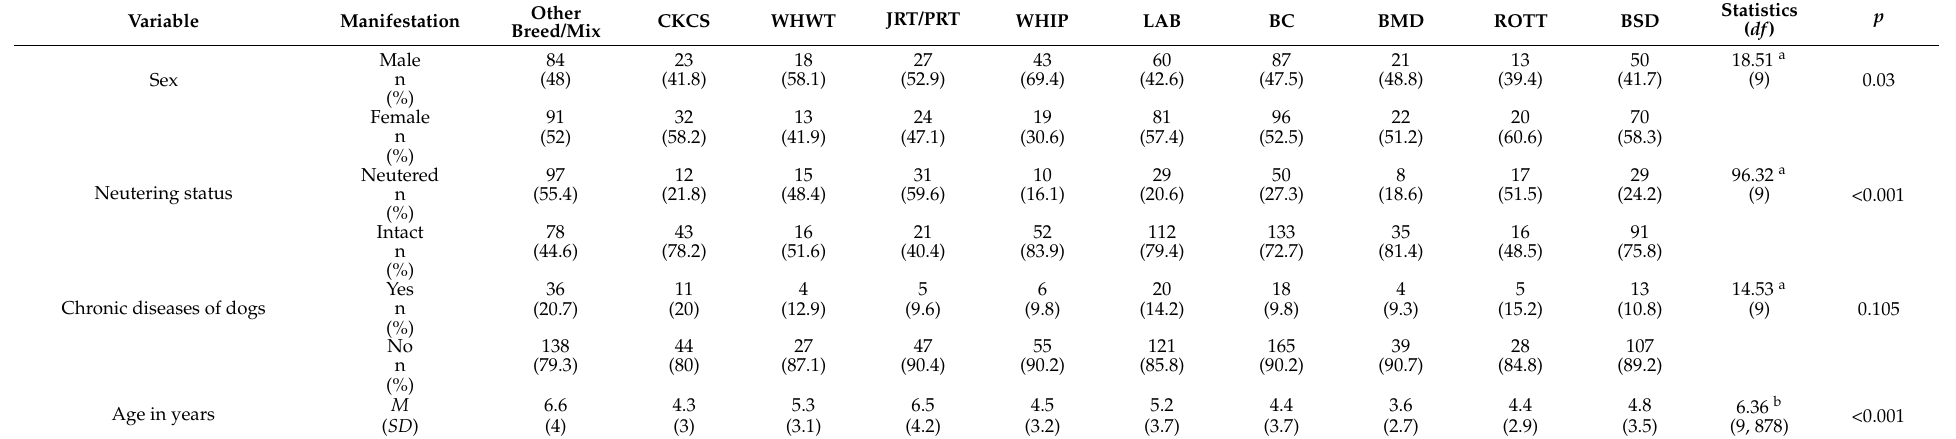
Table 2. Characteristics of the different dog breeds at